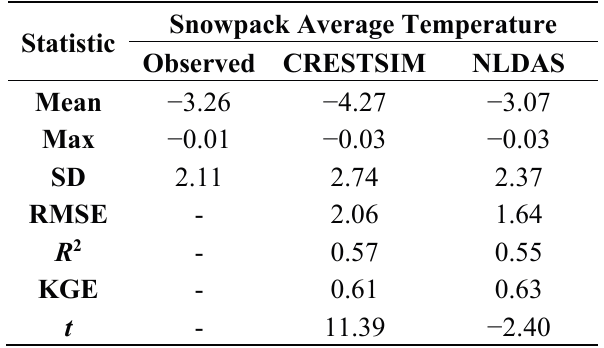
Table 4. Statistics for overall snowpack temperature (°C). Validation